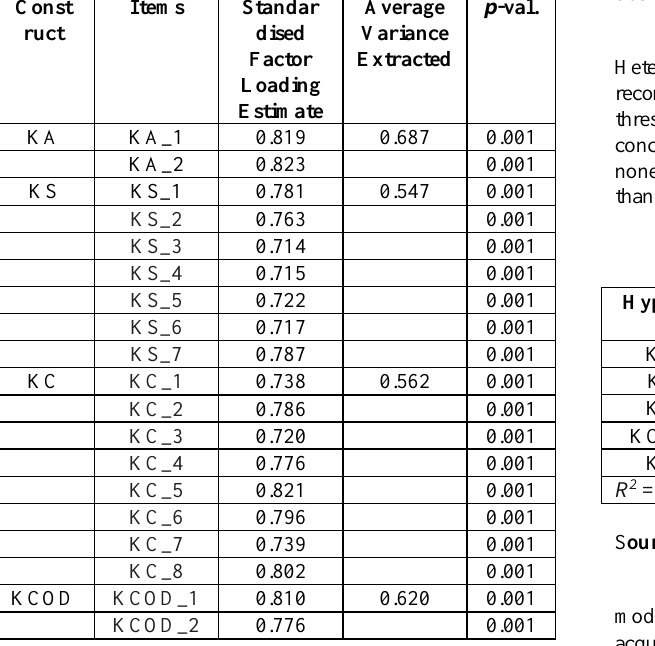
Table 5: Convergent Validity Results for Constructs Const